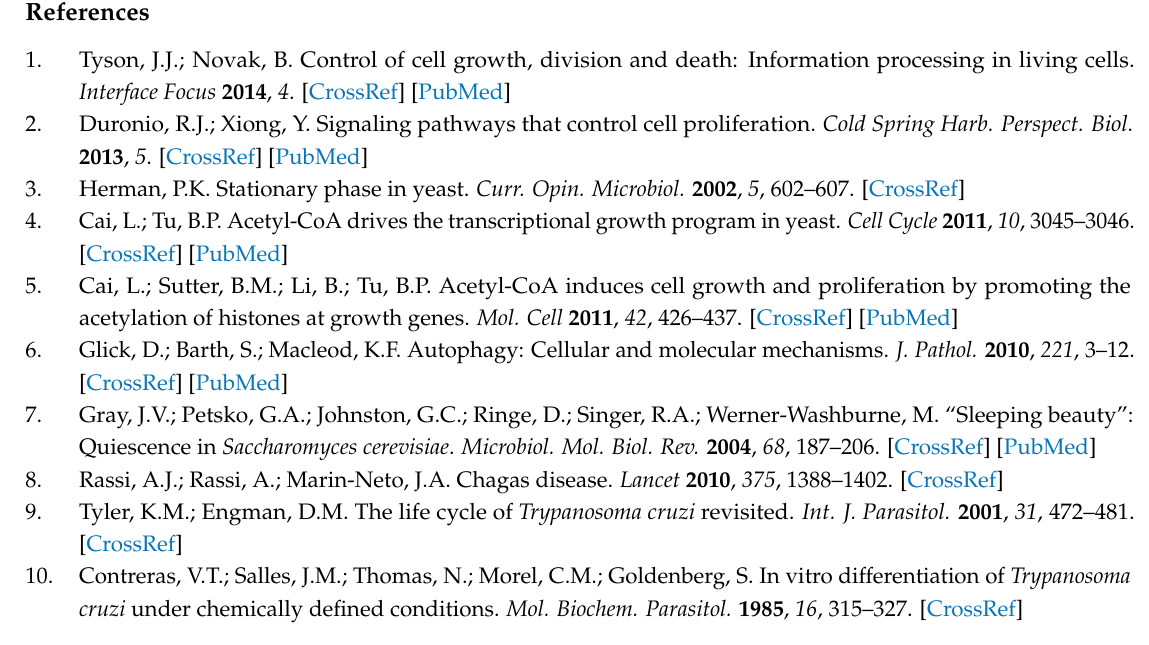
Figure S1: PFAM domains associated to the number of proteins, Figure S2: Phylogenetic analysis of Q4DEL9 uncharacterized protein, Figure S3: Phylogenetic analysis of T.cruzi Nat1 (Q4D4R3), Figure S4: Expression of methionine oxidized peptides between the T.cruzi exponential and stationary phases, Figure S5: PRODH and MDH metabolic pathways regulated during T.cruzi transitioning from exponential to stationary phase, Table S1: Total proteins identified and quantified in the T.cruzi exponential and stationary phase, Table S2: Regulated proteins between the T.cruzi exponential and stationary phase, Table S3: Unique proteins identified and quantified in the T.cruzi exponential and stationary phase, Table S4: Regulated uncharacterized proteins between the T.cruzi exponential and stationary phase, Table S5: N-terminal acetylated peptides identified and quantified during transitioning from exponential to stationary phase, Table S6: Proteins with N-terminal acetyltransferase (Nat) domain, Table S7: Methionine oxidized peptides identified in the T.cruzi exponential and stationary growth